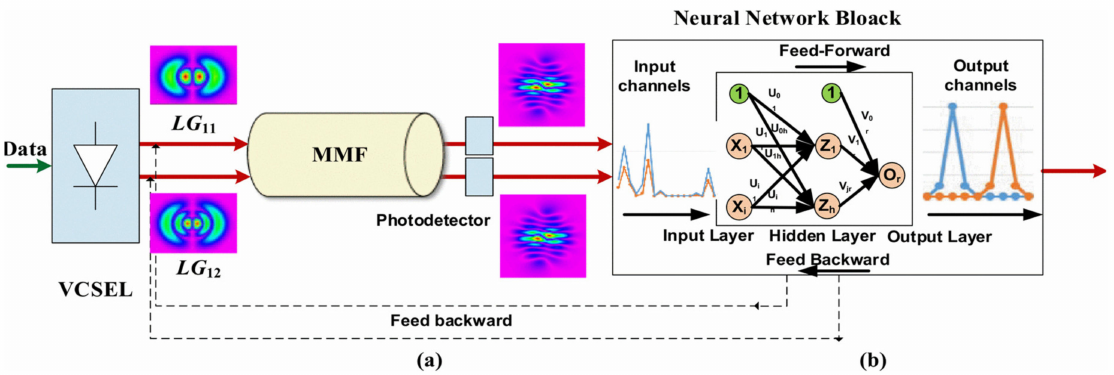
Figure 20. ( a ) MDM transmission system with ANN equalizer; ( b ) The structure of